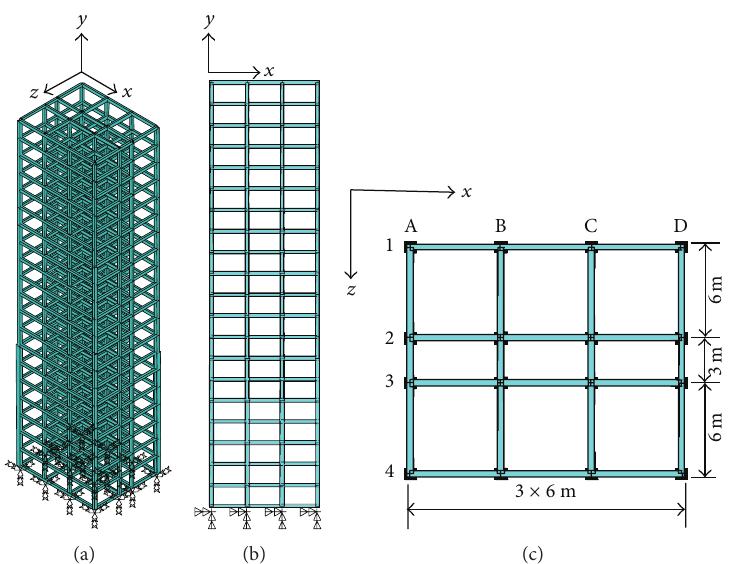
Figure 2: A base-isolated building with 20 storeys: (a) 3D model, (b) evaluation of the frame, and (c) plan view.